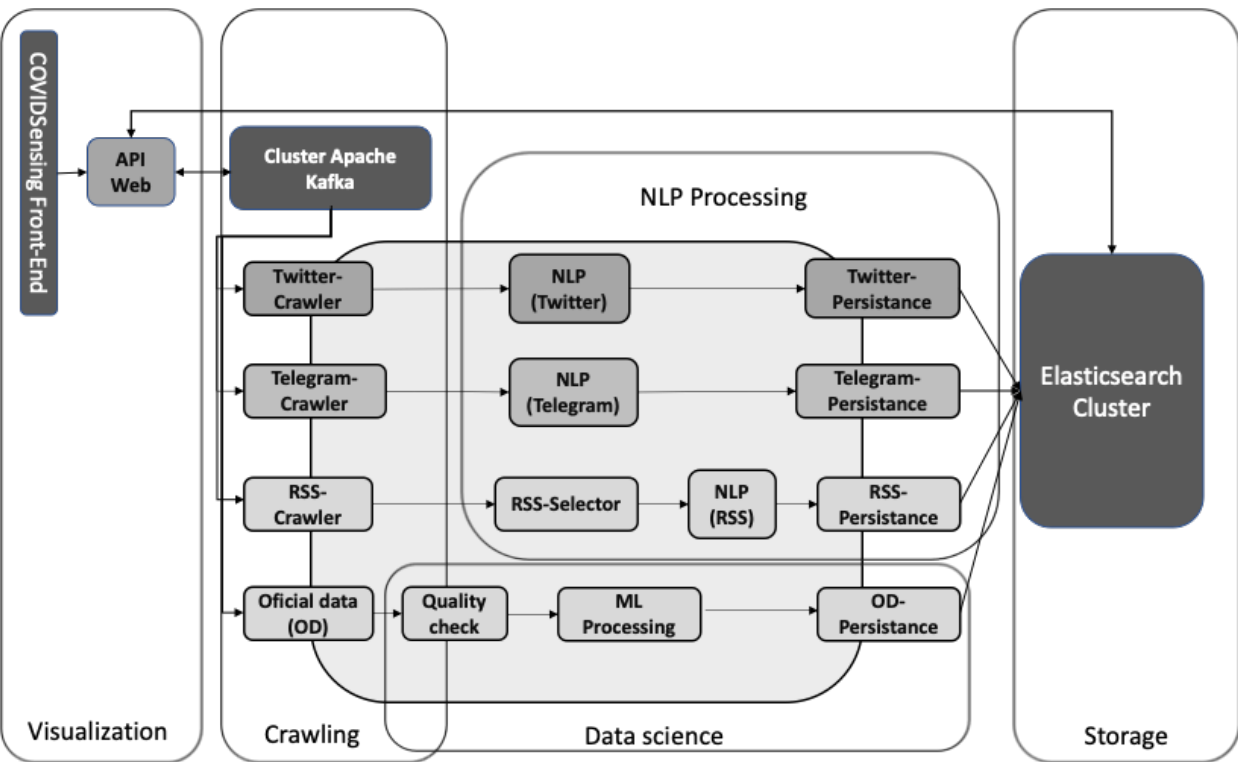
Figure 2. COVIDSensing software